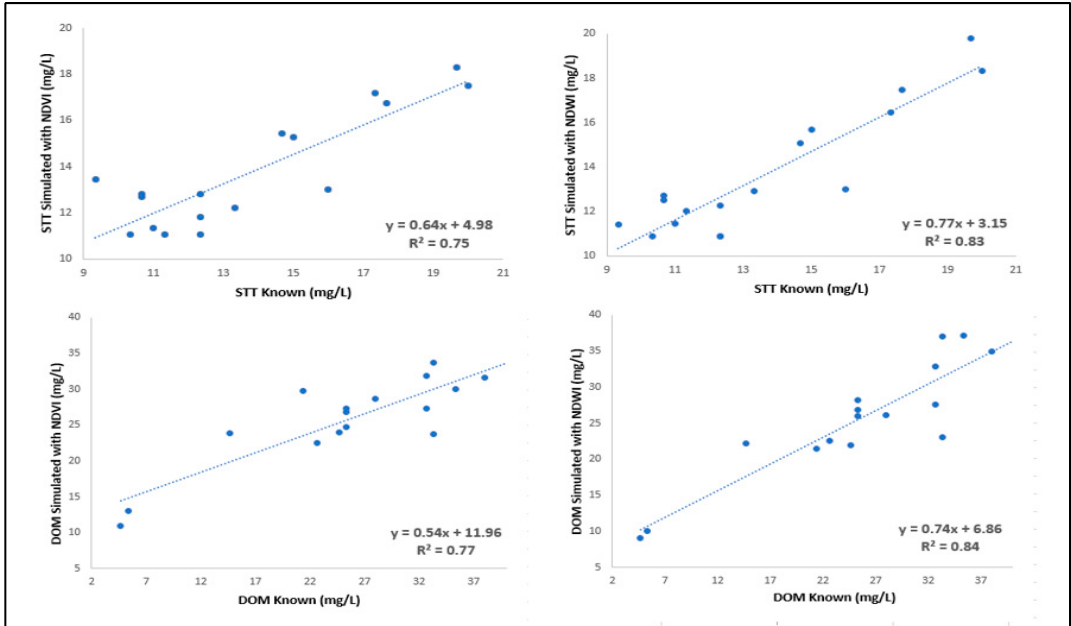
Figure 6. S catter plot of SST and DOM known and simulated considering the b 4 and b 5 bands in obtaining the NDVI and NDWI indices.